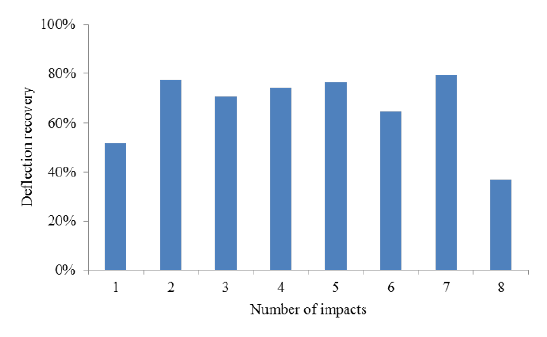
plied from impact #2.